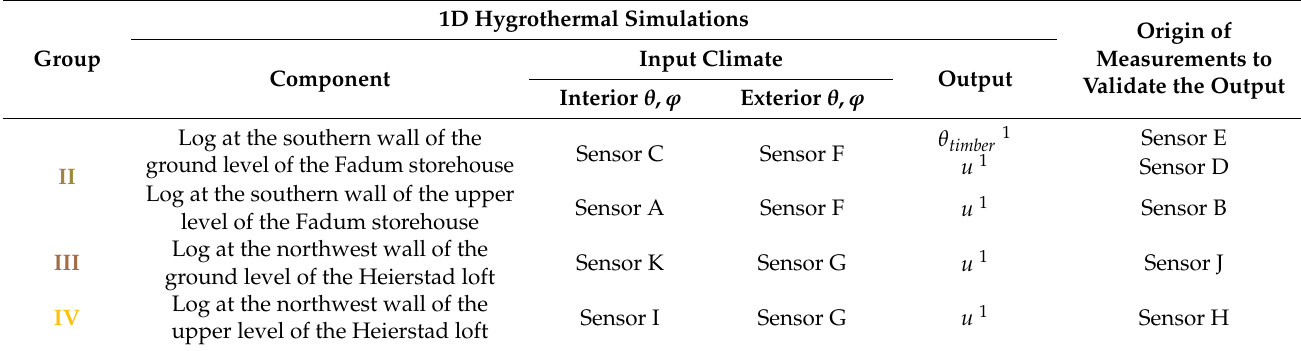
Table 1. Inputs, outputs, and origin of the measurements to validate the outputs of the simulated hygrothermal performance of selected building